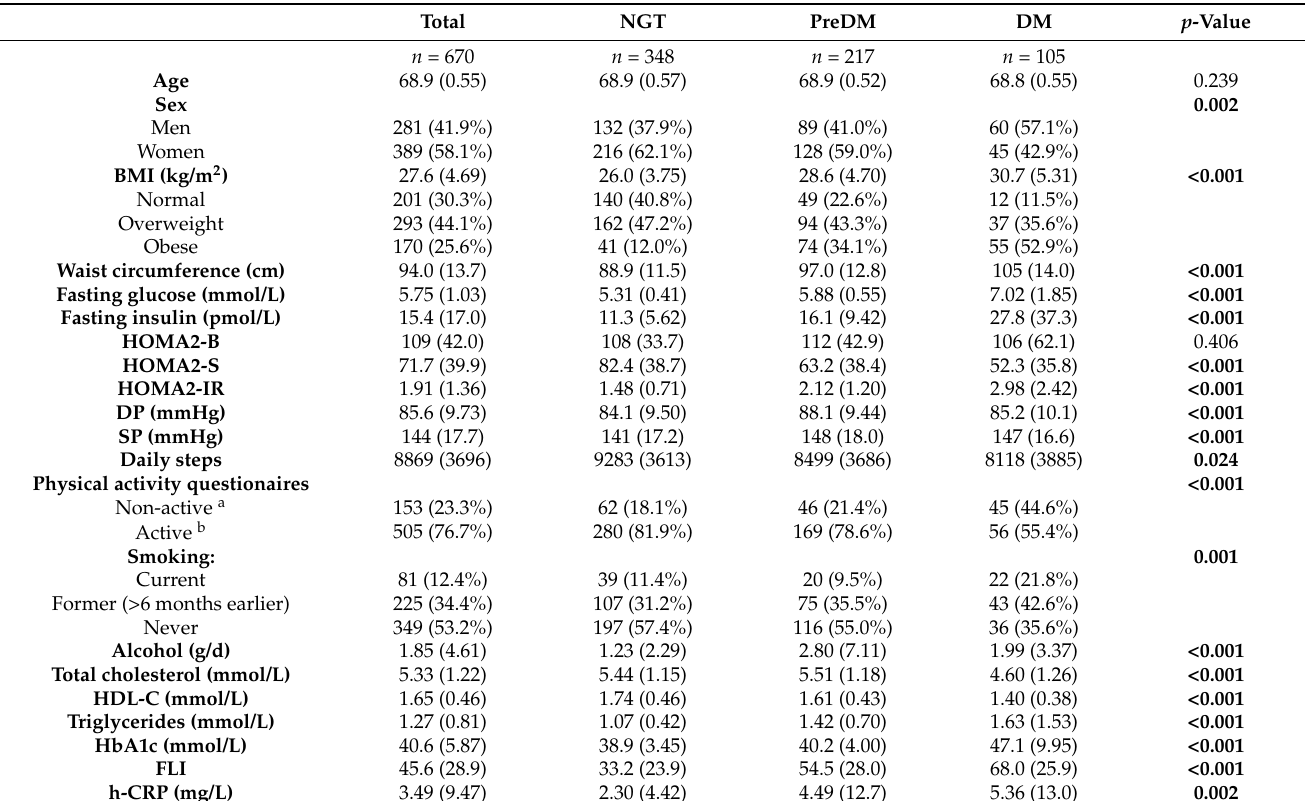
Table 1. Anthropological and biochemical measurements. Means and standard deviations in brackets or numbers and percent of subjects ( n ; %) are shown.